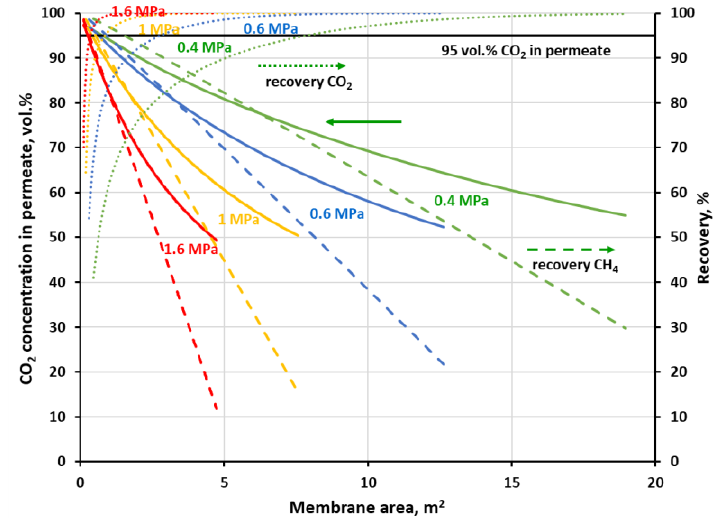
Figure 9. CO 2 concentration (solid lines) and recovery (dotted lines) in permeate along with CH 4 recovery (dashed lines) in retentate against membrane area and feed gas pressure for a one-stage biogas upgrading system with the polyimide (UBE UMS-A5) membrane.